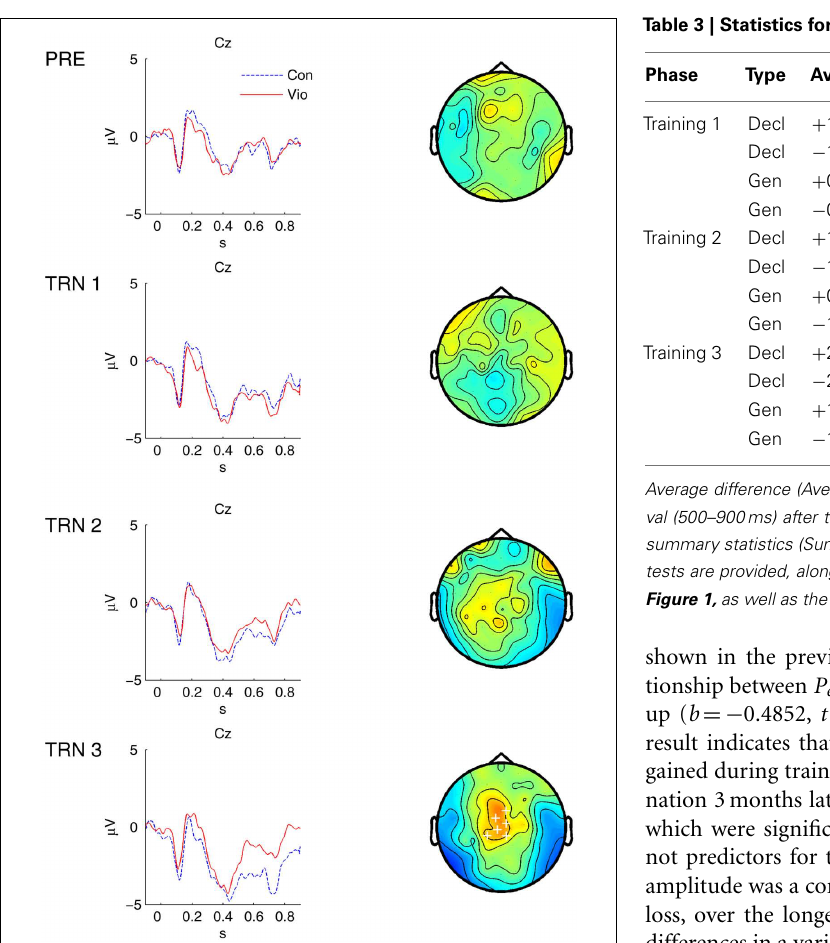
FIGURE 3 |Average event-related potentials for gender violation contrast (4 word). Trace plots indicate average voltage (in μ V) as a function of time at Cz/1; control = Con (blue, dotted line), violation = Vio (red, solid line). Symbols plotted on the topographical plots indicate membership within a statistically significant negative (“ − ”) or positive (“ + ”) cluster of electrodes.Topographical plots are viewed from the top (left is on the left-hand side).